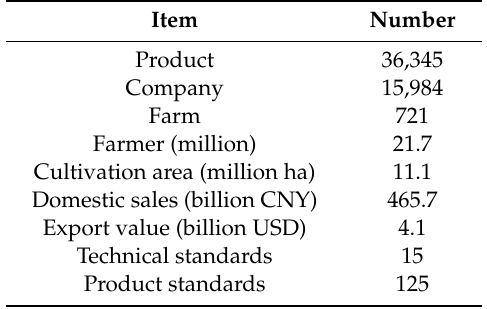
Table 2. Current status of the green food industry in China in 2019 (Source: CGFDC).